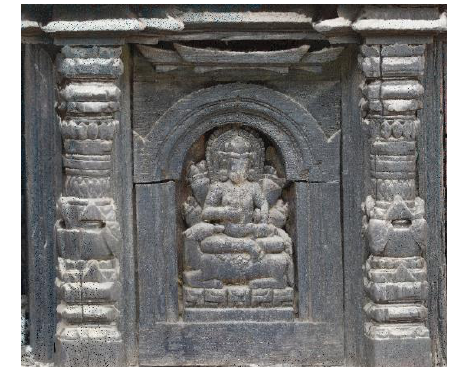
Figure 4. 3D model of a mini statue of a temple in Bhaktapur.